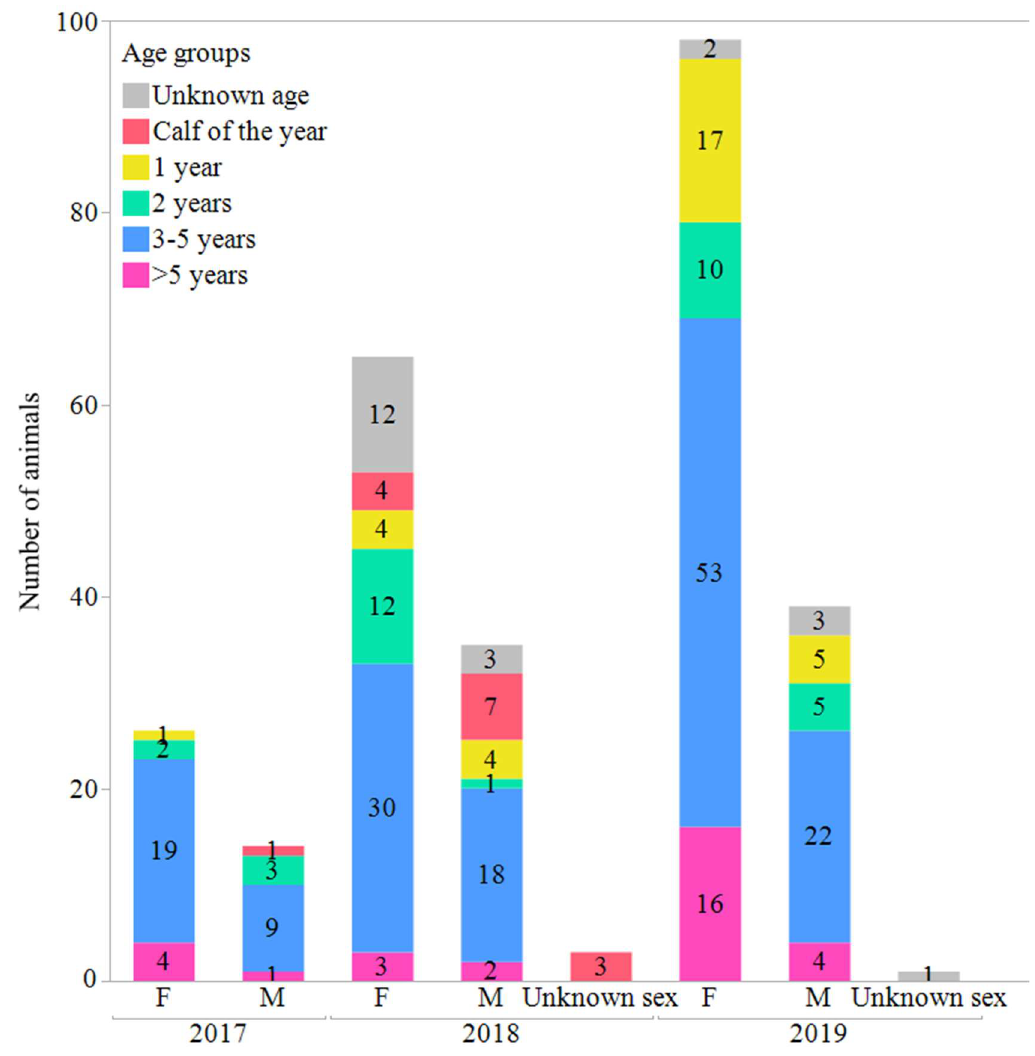
Figure 1. Distribution of wild Icelandic reindeer ( n = 281) sampled in 2017–2019 and tested for ex- posure to selected viral